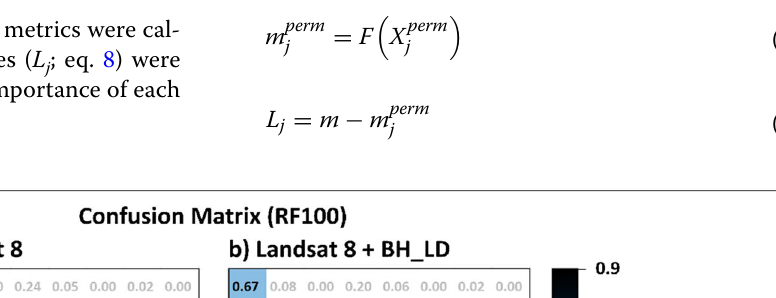
BH_LD, c LS8 GMIS, and d LS8 + +